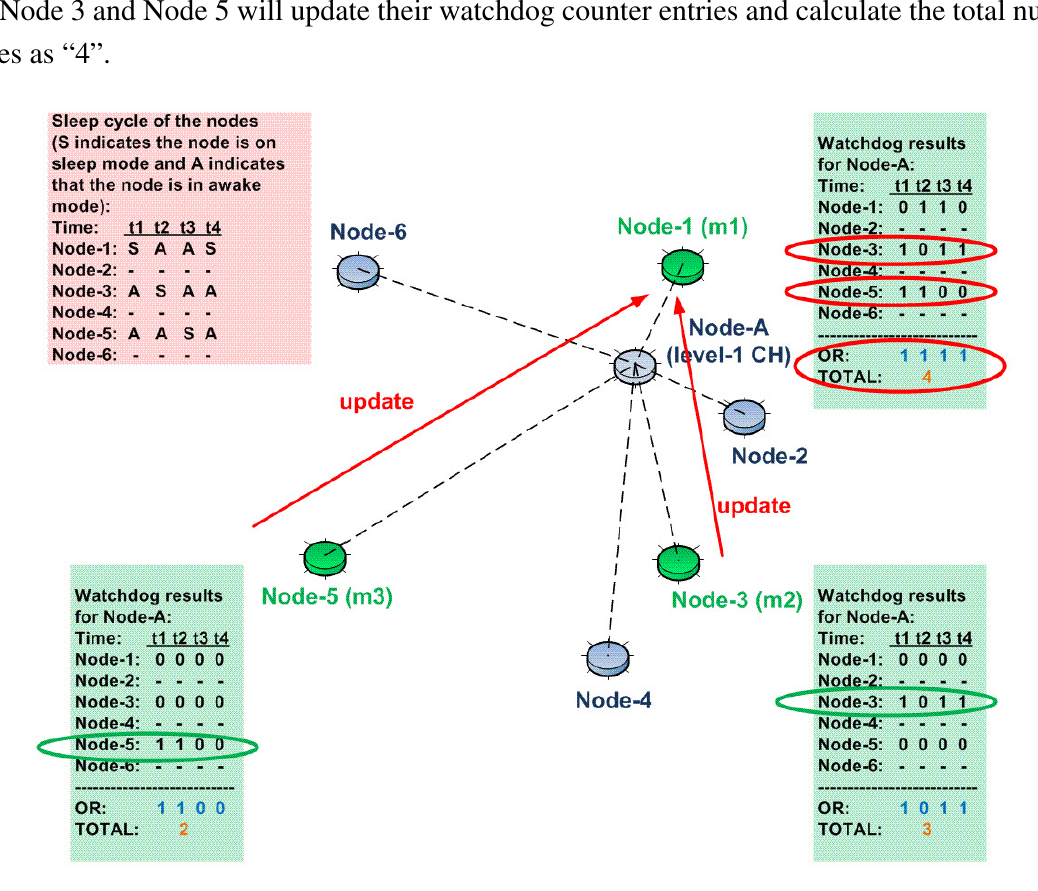
Figure 7. Watchdog update propagation in our